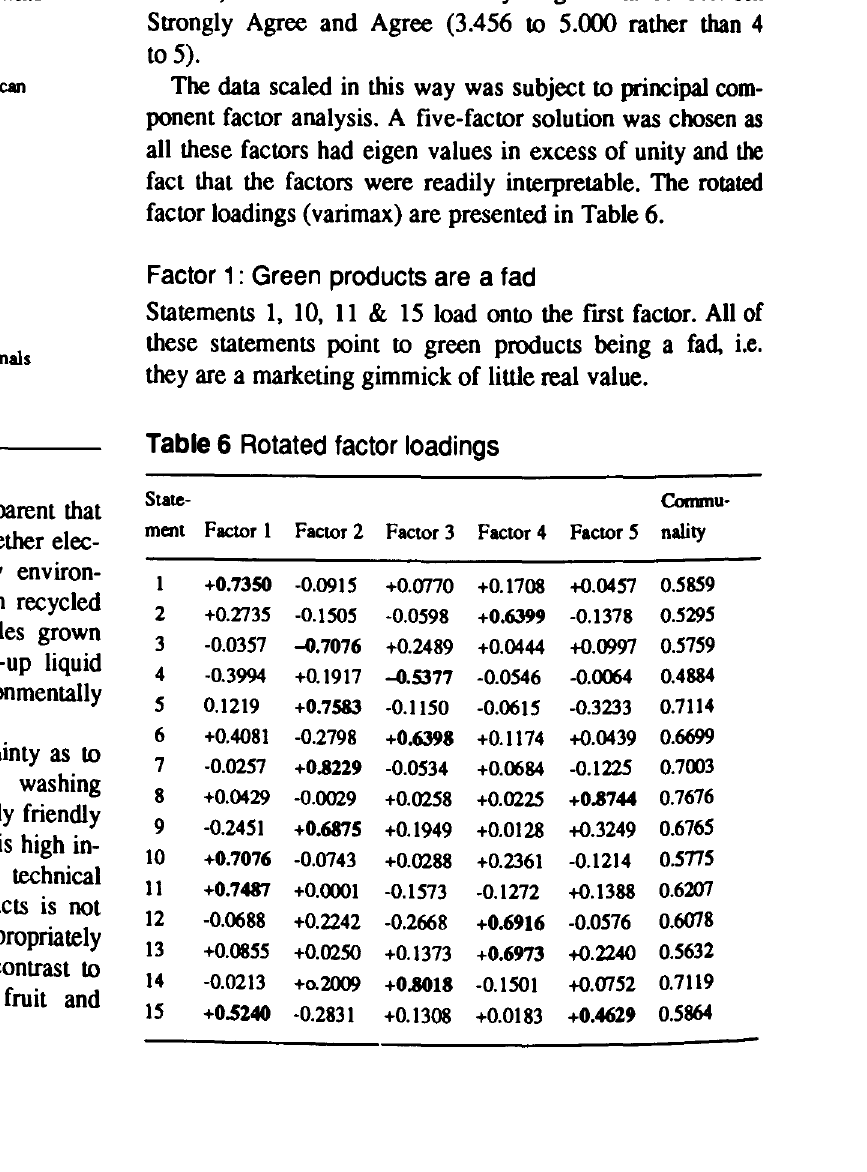
Table 4 Mean rating of